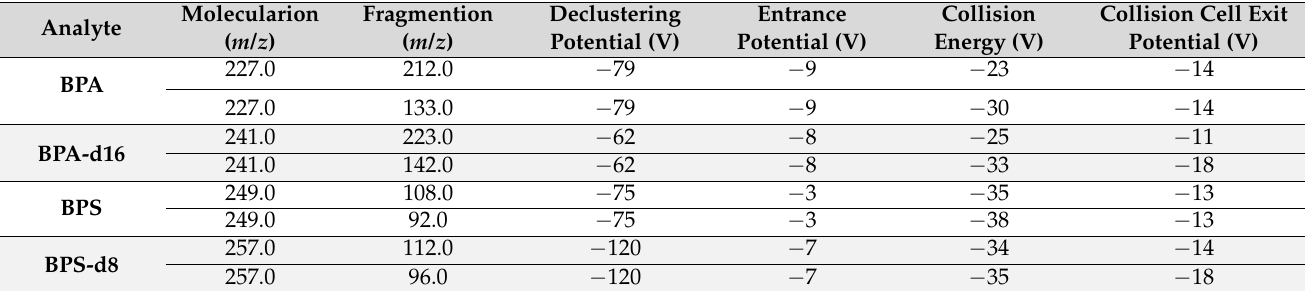
Table 1. MS/MS parameters for bisphenol A (BPA) and bisphenol S (BPS) analyses.